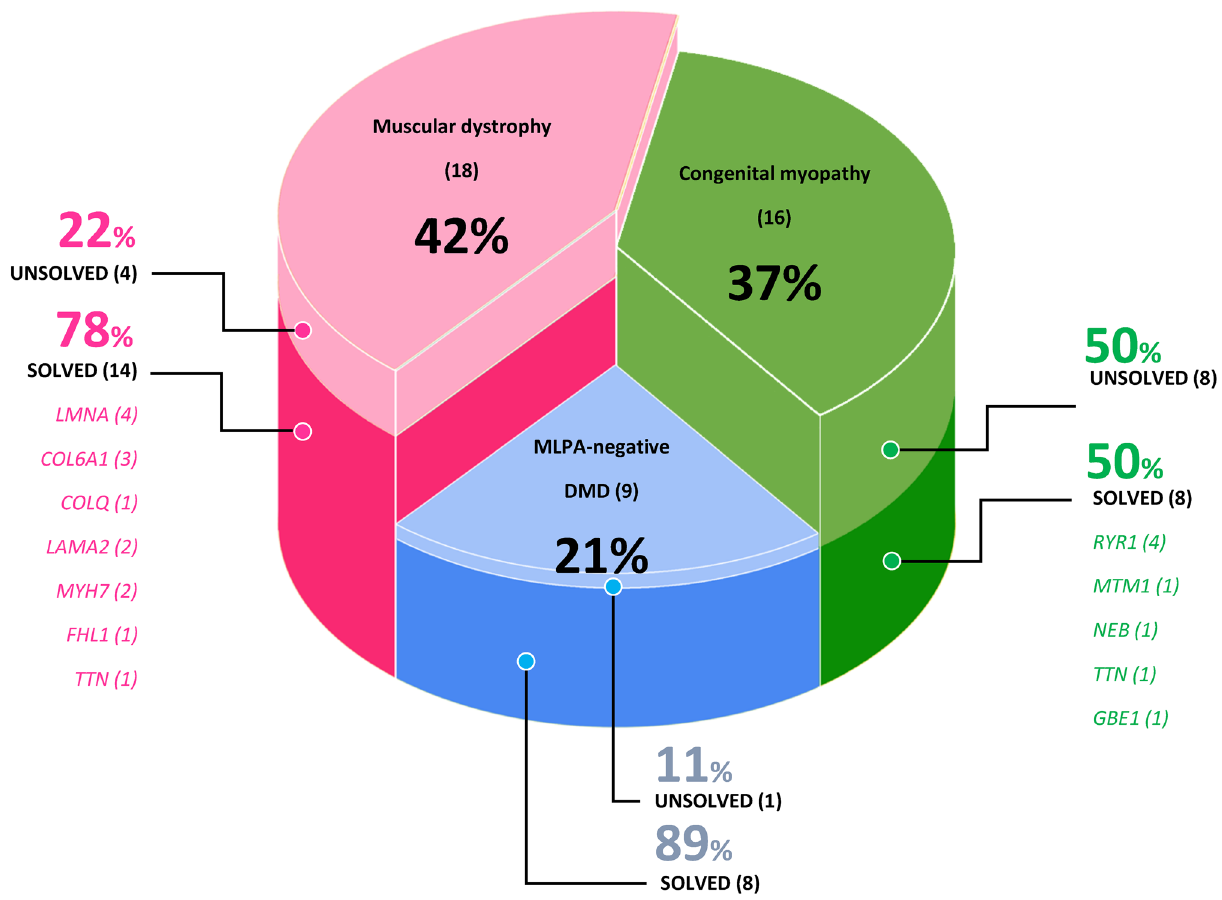
Figure 2. Molecular diagnoses by disease group. Molecular diagnoses using exome sequencing were established in 70% of the patients. The number of patients is given in